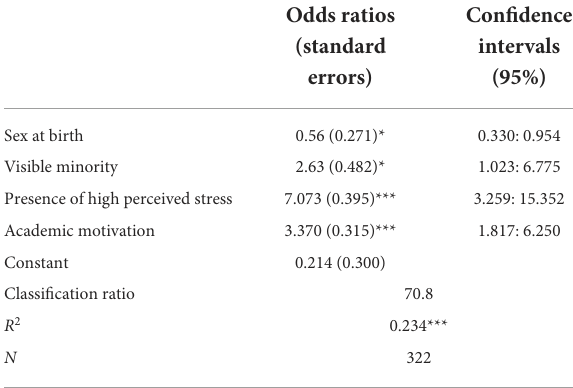
TABLE 2 Multiple binary logistic regression of the presence of depressive